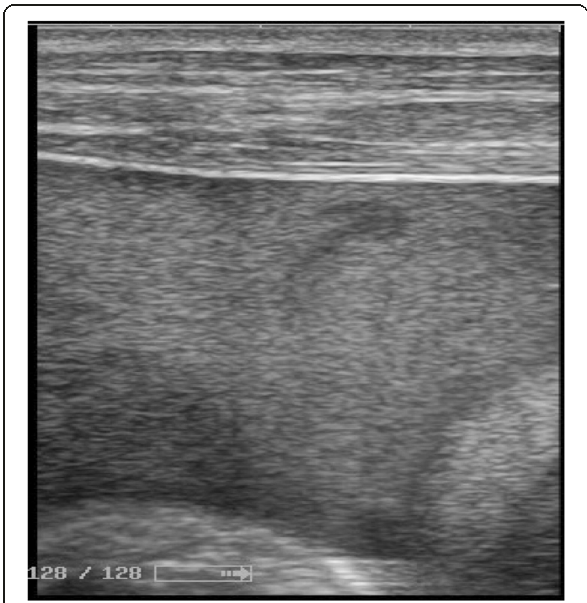
Fig. 3 Ultrasound image of an intraperitoneal effusion containing multiple mobile echoes emphasizing its hematic